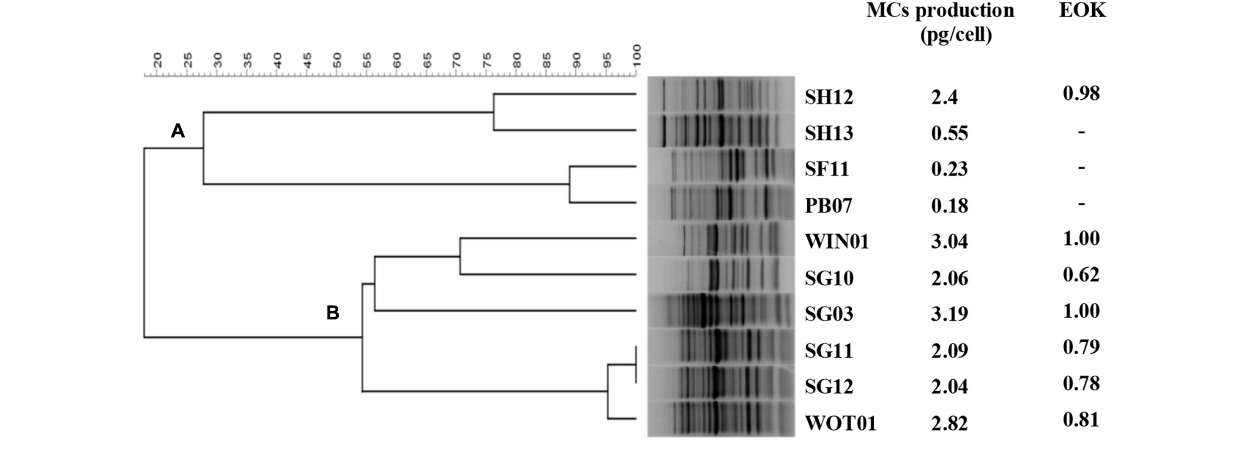
at 30 and 40 ppt. PhiMa05 can also tolerate a wide range